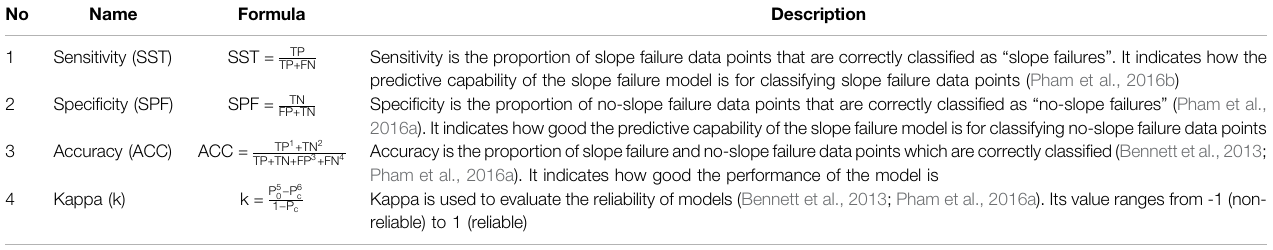
TABLE 2 | Description of performance measures for evaluating ML